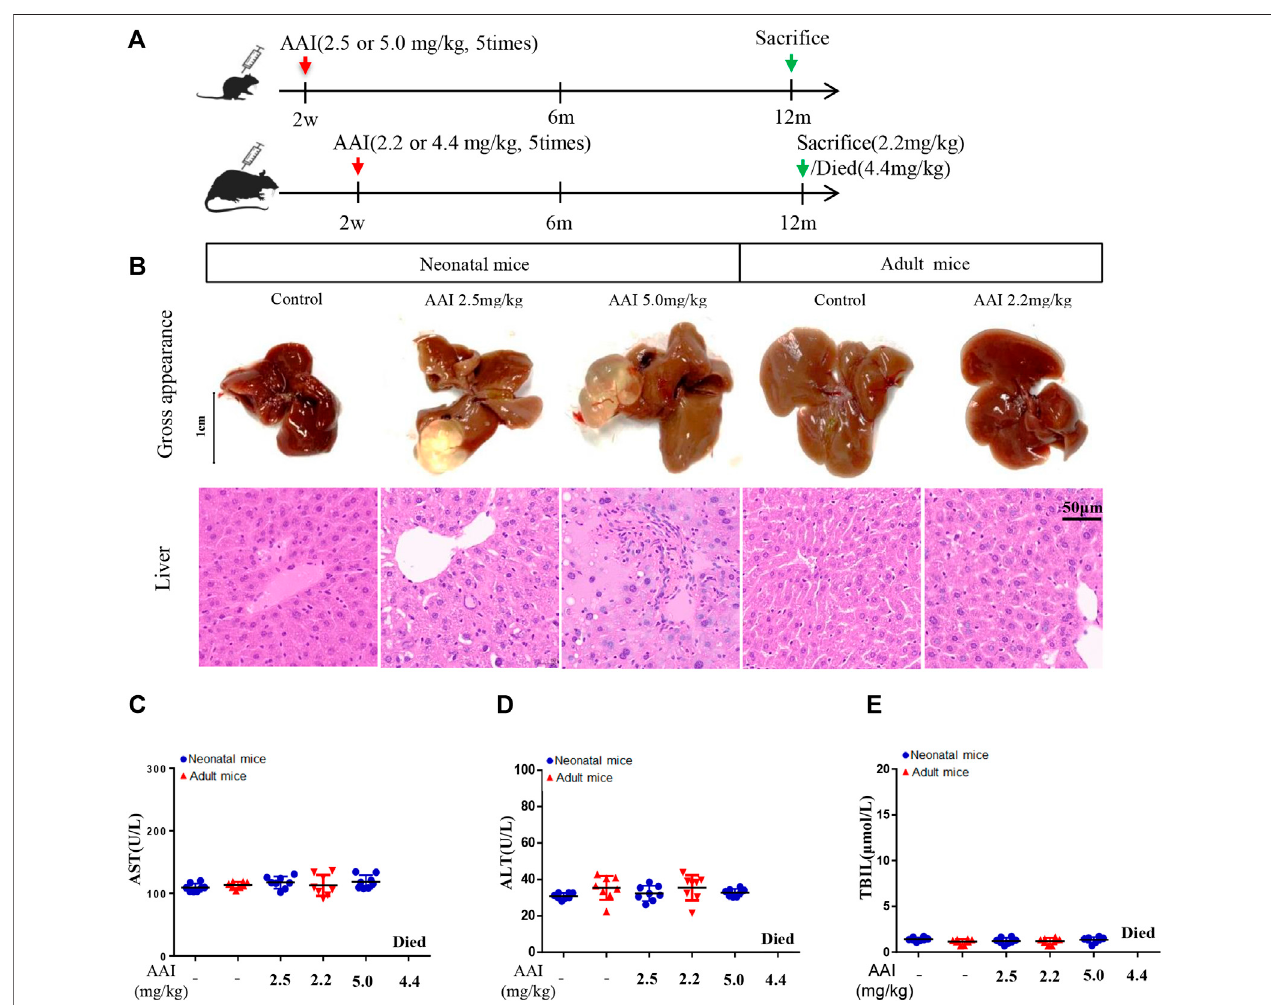
FIGURE 2 | AAI induced serious liver injury in neonatal mice compared to adult mice based on long-term observation. (A) Schematic diagram of the study design. Fifty-twoweeksofobservationafterAAIwasadministered byintraperitonealinjection(onceadayfromMondaytoFridayforatotalof5 days). (B) Representativeimages of AAI-induced liver. The panel includes gross appearance (scale bars, 1 cm), and hematoxylin and eosin staining (scale bars, 50 μ m). Clinical biochemical parameters: (C) aspartate aminotransferase; (D) alanine aminotransferase; and (E) total bilirubin. Data are shown as the mean ± SD. Asterisks above a group between groups (cid:129) (cid:129) indicate a signi fi cant differences: ▲▲▲ p < 0.001, ▲▲ p < 0.01, ▲ p < 0.05 vs. neonatal mice control group; △△△ p < 0.001, △△ p < 0.01, △ p < 0.05 (cid:129)(cid:129)(cid:129) (cid:129)(cid:129) (cid:129) (cid:129) (cid:129) controlgroup; p < 0.001, p < 0.01, p < 0.05 vs. neonatal micelow-dose group; ○○○ p < 0.001, ○○ p < 0.01, ○ p < 0.05